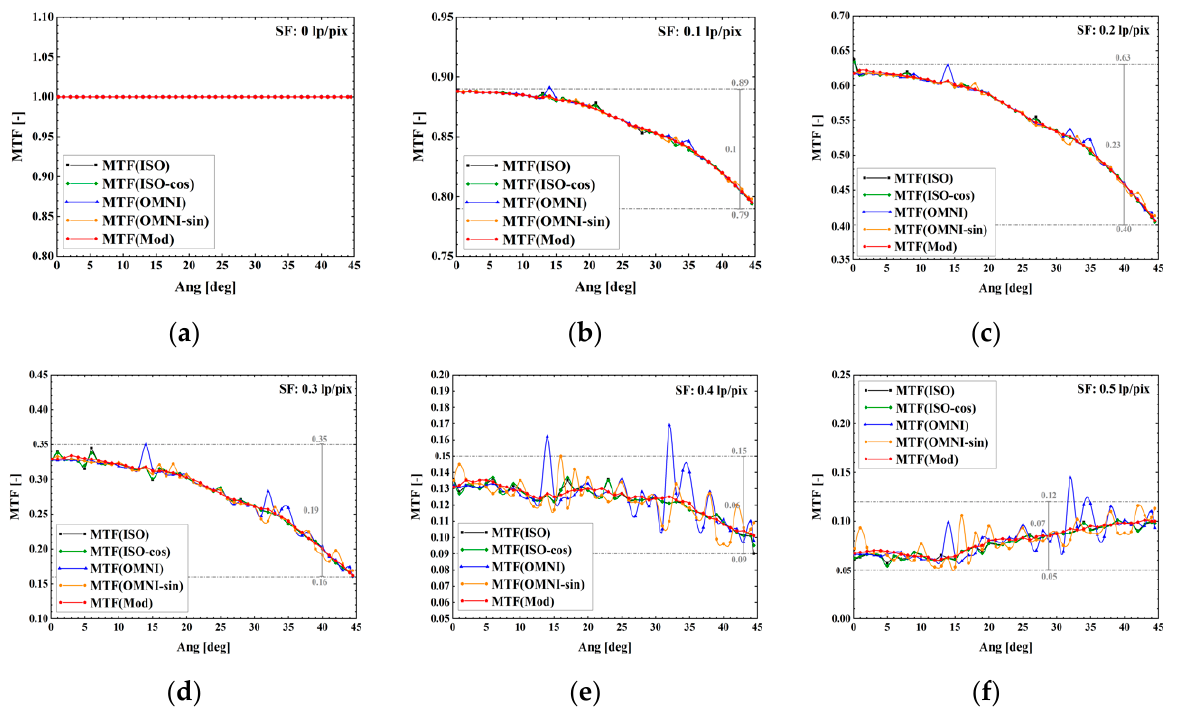
Figure 17. Simulation comparison: proposed method vs. other methods at specific SF points: ( a ) when SF is 0 lp/pix, ( b ) when SF is 0.1 lp/pix, ( c ) when SF is 0.2 lp/pix, ( d ) when SF is 0.3 lp/pix, ( e ) when SF is 0.4 lp/pix, ( f ) when SF is 0.5 lp/pix (Nyquist frequency).